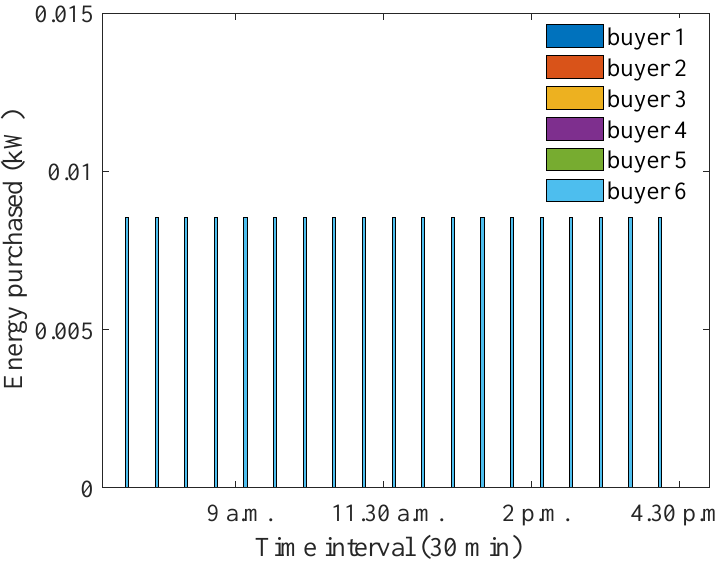
Figure 26. Optimum energy purchased for equally preferred sellers and buyers when distance between house 4 and the aggregator is